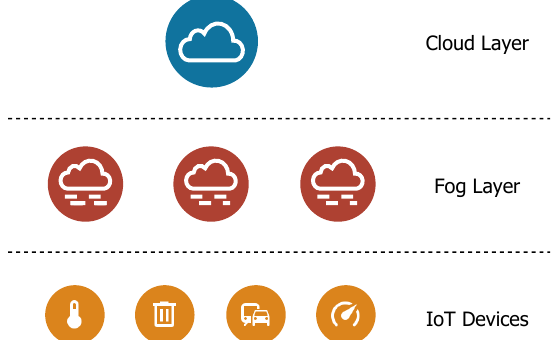
Figure 1. Three-layer fog computing architecture